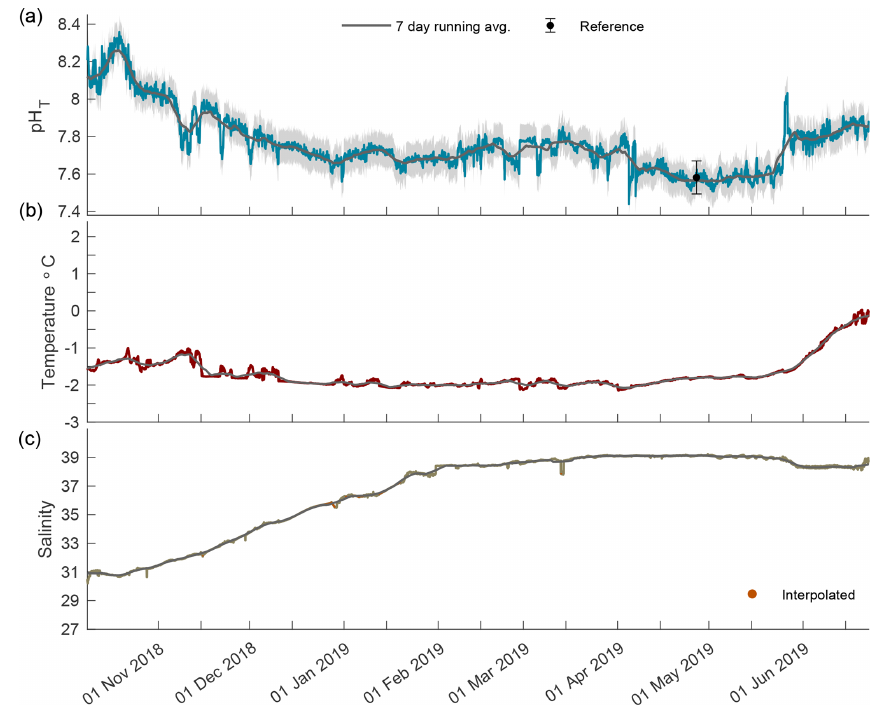
Figure 4. The 2018/19 closed-phase time series of pH T (a) , temperature (b) , and salinity (c) in Kaktovik Lagoon.